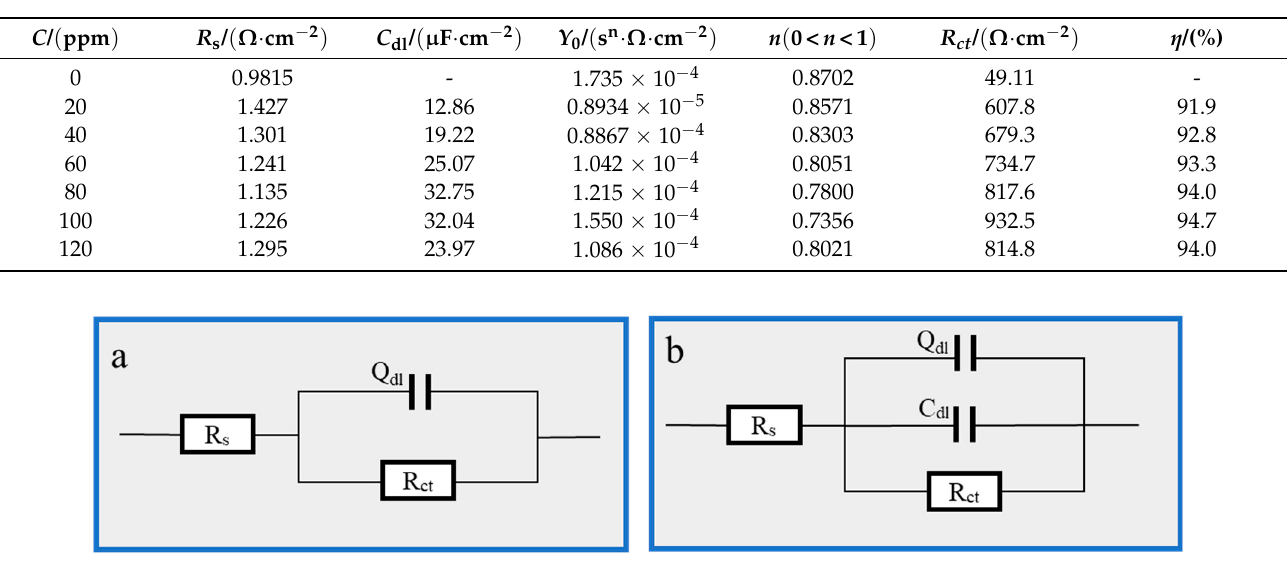
Table 3. Tafel curves parameters of Q235 carbon steel in solutions containing di ff erent concentra- Table 3. EIS curves parameters of Q235 carbon steel in solutions containing different concentrations tions of Cu(II)@Thy-2. of Cu(II)@Thy-2.